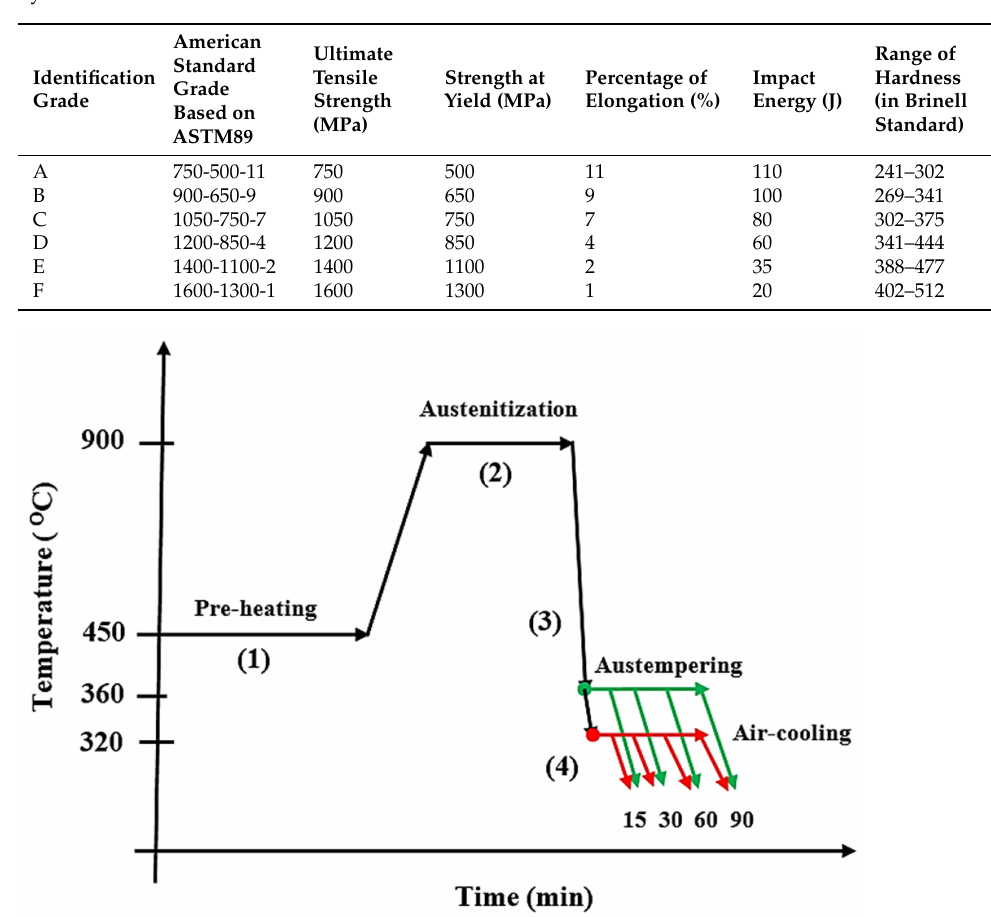
Table 3. Different types of austempered ductile iron and their mechanical properties as designated by ASTM A897-A897M-06.